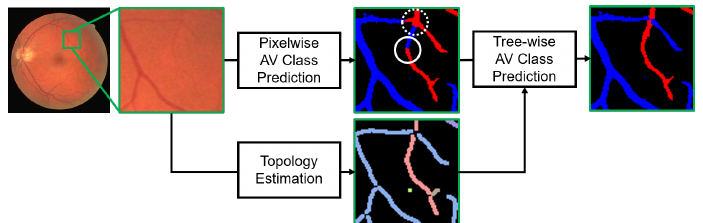
Figure 1. Illustration of our topology-aware retinal artery–vein (AV) classification method, where estimated vessel topology is used to perform tree-wise AV classification. Red and blue colors represent classified arteries and veins, respectively. Different colors in the estimated topology map represent separate sub-trees. Tree-wise AV classification is used to correct the pixelwise classification errors on thin vessels, highlighted by white circles, which may occur due to their indistinct